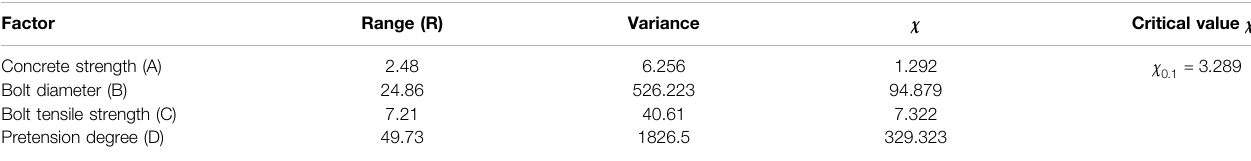
TABLE 3 | Range and variance analysis results of the initial slip force of HSFGBs. Factor Range (R) Variance χ Concrete strength (A)